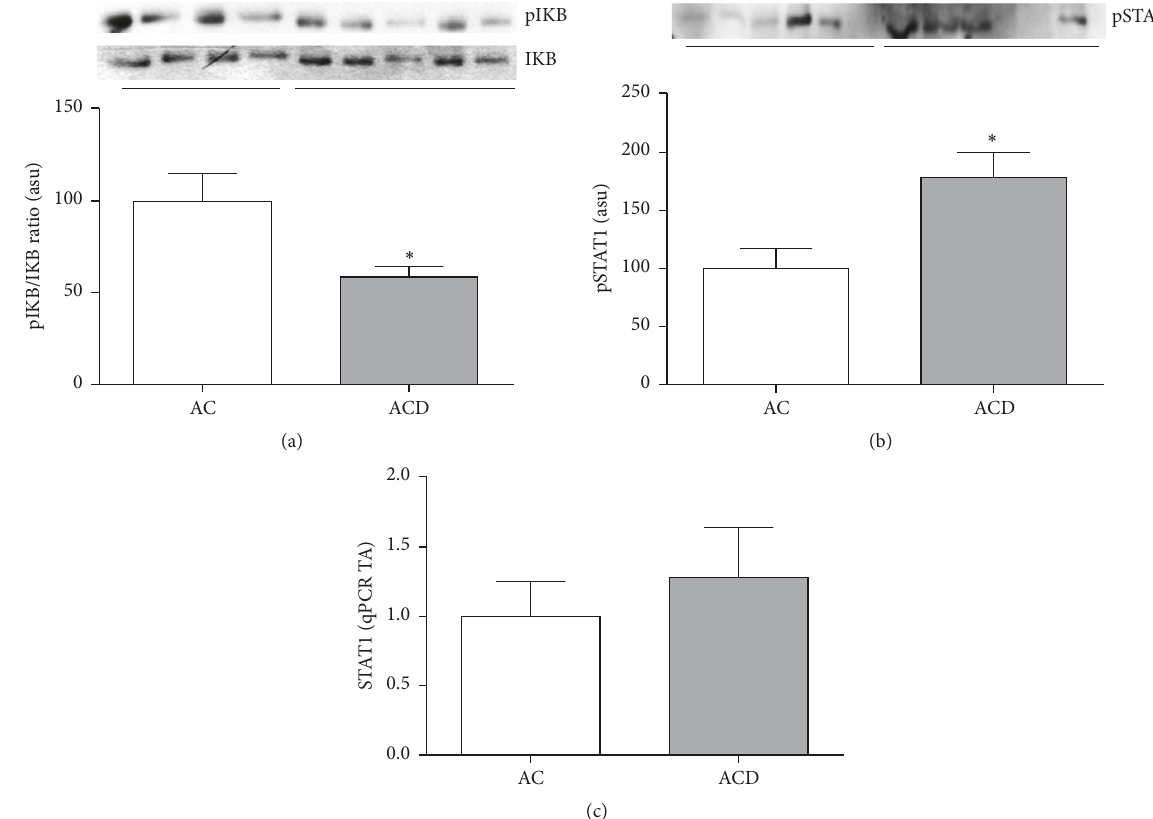
Figure 5: Mesenteric adipose tissue of Crohn’s disease patients shows activation of STAT1 transcriptional pathway. Western blot analysis of pI 𝜅 B/I 𝜅 B ratio (a) and pSTAT1 (b) in the mesenteric adipose tissue (MAT) of CD patients (ACD Group) compared to controls (AC Group). mRNA levels (qRT-PCR) of STAT1 (c) in MAT of CD patients (ACD Group) when compared to controls (AC Group). Each band represents one patient. For ACD, 𝑛 = 10 ; and, for AC, 𝑛 = 8 , ∗ 𝑝 < 0.05 , ∗∗ 𝑝 < 0.01 , and ∗∗∗ 𝑝 < 0.001 versus control. ASU: arbitrary scanning unit; TA: transcription